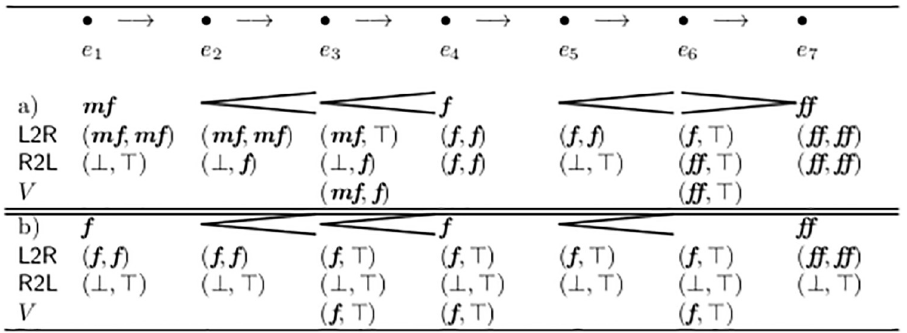
Fig 10. Examples of V-analysis